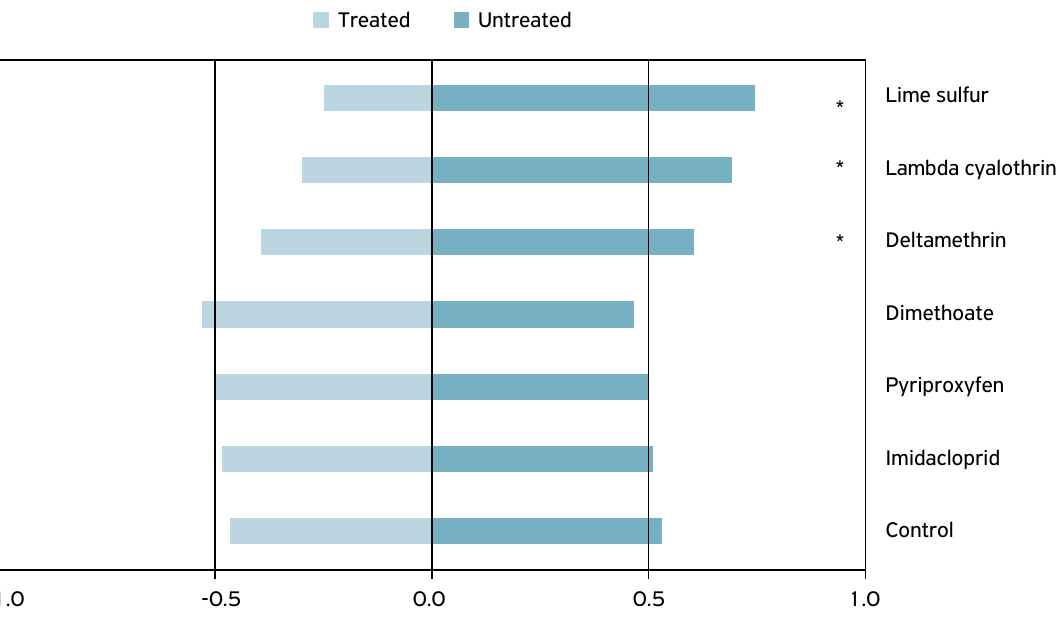
Figure 5. Preference of adult Panonychus citri females for insecticide treated and untreated